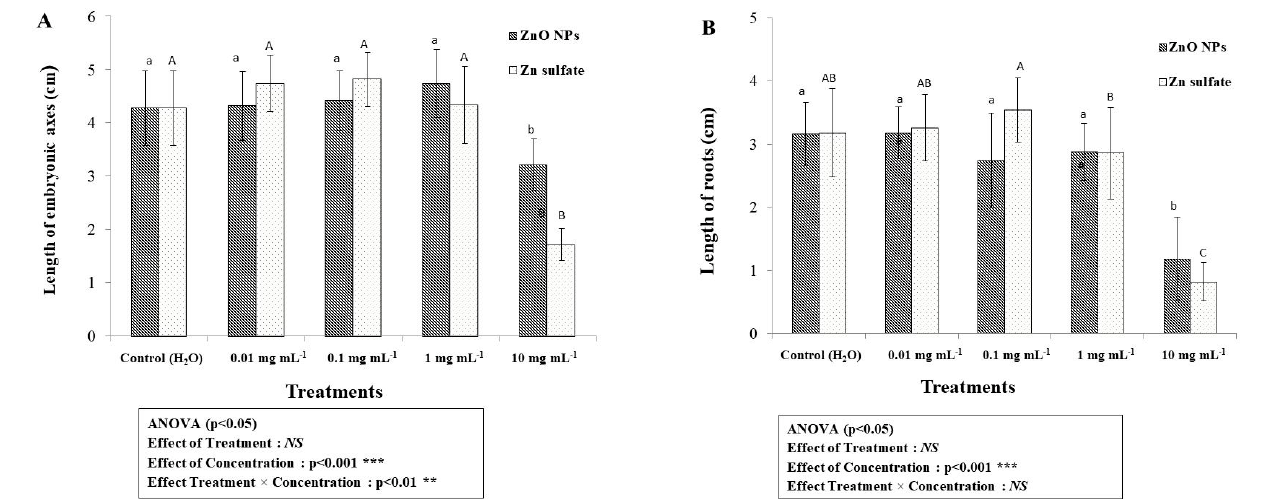
Fig. 2: Length of the embryonic axes (A) and the roots (B) of Lathyrus sativa L. seeds germinated for 4 days in the presence of distilled water (Control) or solutions of ZnO NPs and ZnSO 4 at concentrations 0.01 mg ml -1 , 0.1 mg ml -1 , 1 mg ml -1 and 10 mg ml -1 . Values are means (±SD) of 5 independent measurements. Letters a,b and A-C denote statistic classes, respectively, for ZnO NP and Zn sulfate, using Duncan test (α=0.05). Differences are significative, at *: 0.01≤P<0.05, **: 0.001≤P<0.01, ***: P<0.001, and non significant NS at